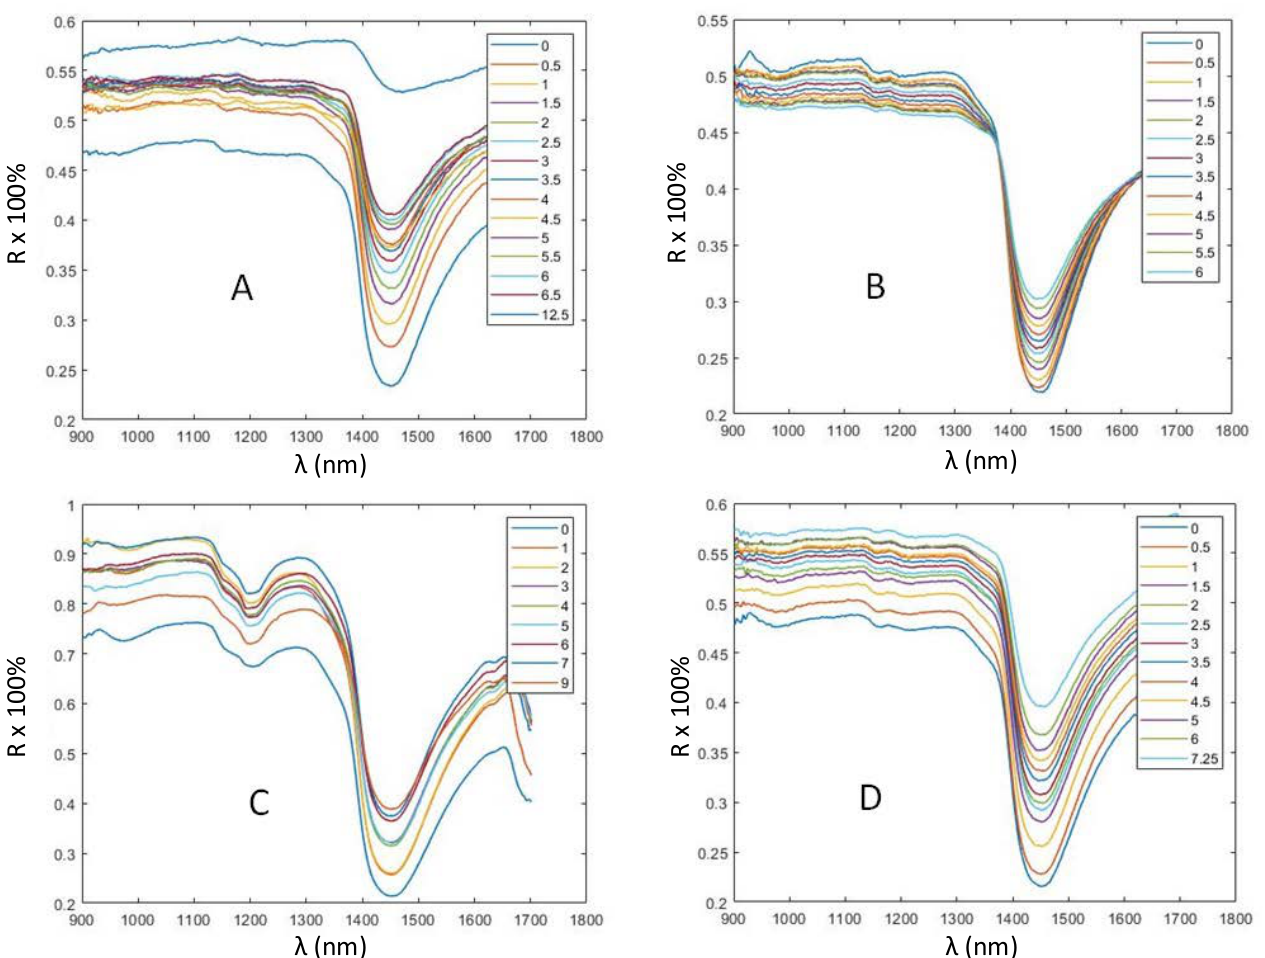
Figure 5. Reflectance spectra of test subjects: ( A ) leaf of common dandelion, ( B ) cloverleaf, ( C ) lettuce leaf, and ( D ) blade of grass.